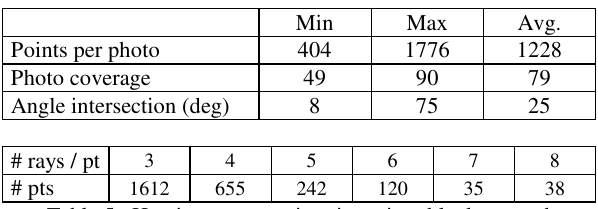
Table 5. Herzjesu, automatic orientation: block strength statistics Figure 4. Orientation of fountain sequence. Top : camera stations, tie points (white) and check points (red). Bottom : the textured DSM obtained by dense